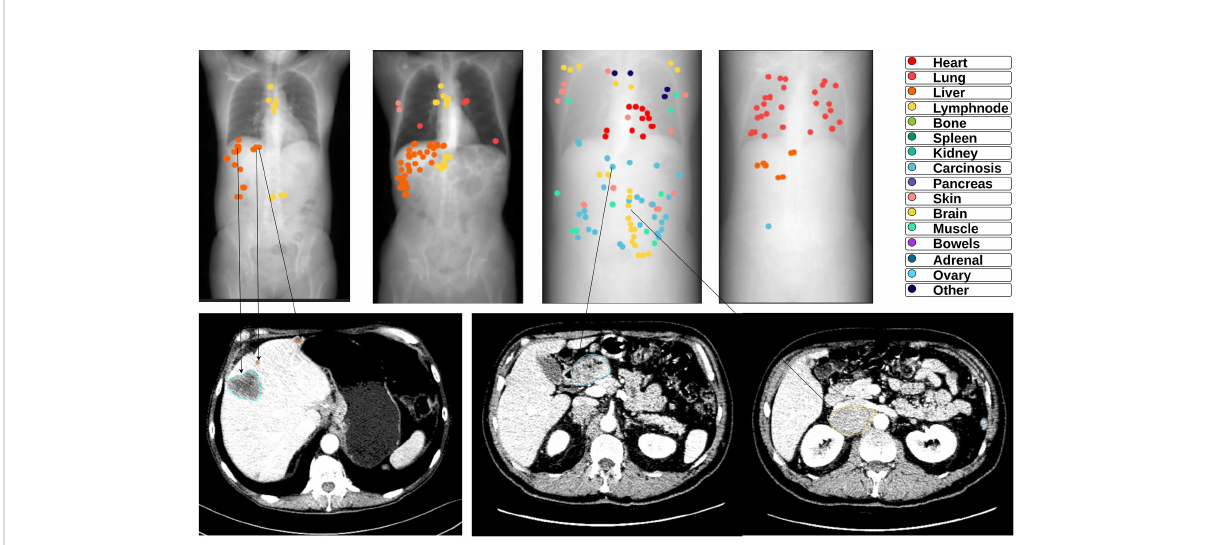
FIGURE 1 Examples of annotations on CT scans of different metastatic patients at baseline. The upper part contains an overview (CT Scout image) of the thorax- abdomen-pelvis CT scans that were fully annotated. Each colored dot in the overview is an annotation on its corresponding axial slice, the color indicates the tumor location or type (See Figure legend). The lower part shows a few examples of the tumor annotations on the axial